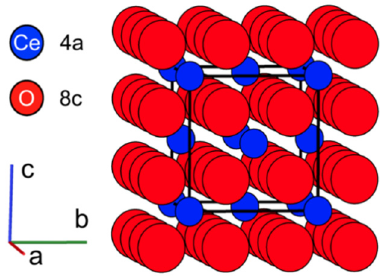
Figure 1. The cubic fluorite structure (space group Fm-3m ) of CeO 2 , where cations (blue spheres) occupy 4a Wykoff sites and anions (red spheres) occupy 8c sites.